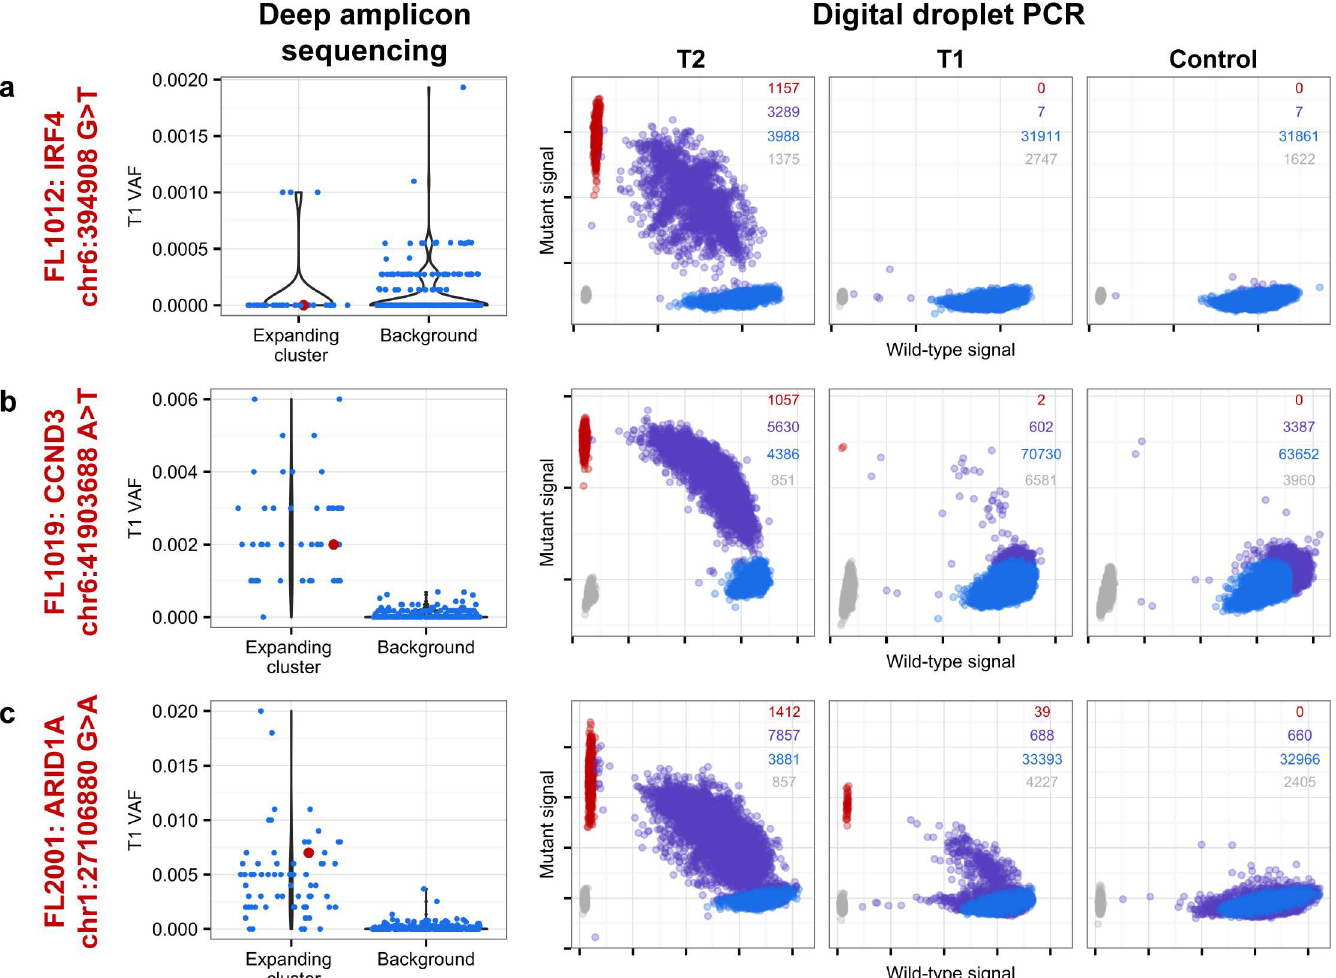
Fig 5. Ultra-sensitive detection of low prevalenceclones in T1 samples. Shown are three mutations (A–C) in three patients (FL1012, FL1019, and FL2001) in which PyClonesuggestedthat the expanded T2-dominant mutation clusters were present at near zero prevalence at T1. No evidenceof read support, when comparedto background, was found for the T2-associated mutation in the T1 sample for case FL1012, in contrast to cases FL1019 and FL2001 (leftmost plots). Backgroundrefers to variant allelefrequencies of all possiblesingle nucleotide changesin the vicinity of the mutation of interest (definedas up to 50 base pairs upstream and up to 50 base pairs downstream). The results are confirmedby digital droplet PCR (rightmost plots). Color coding in the digital droplet PCR plots is as follows: grey = empty droplets; blue = single-positive droplets for wild-typeallele; purple= double-positive droplets; red = single-positive droplets for mutant